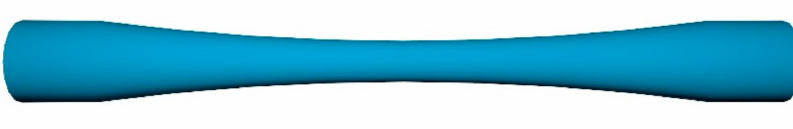
Figure 3. The schematic diagram of tapered